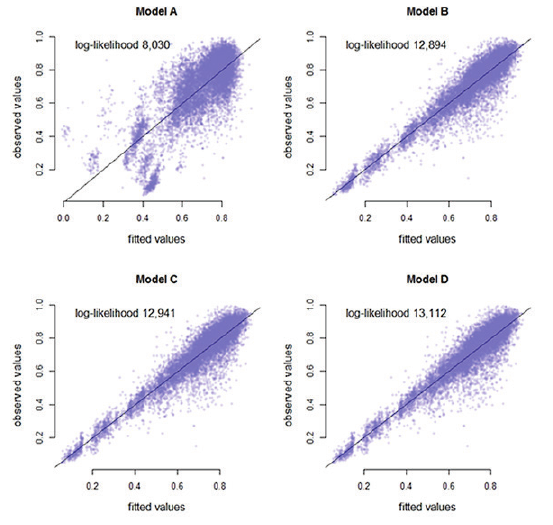
Figure 6. Goodness of the fi t of models